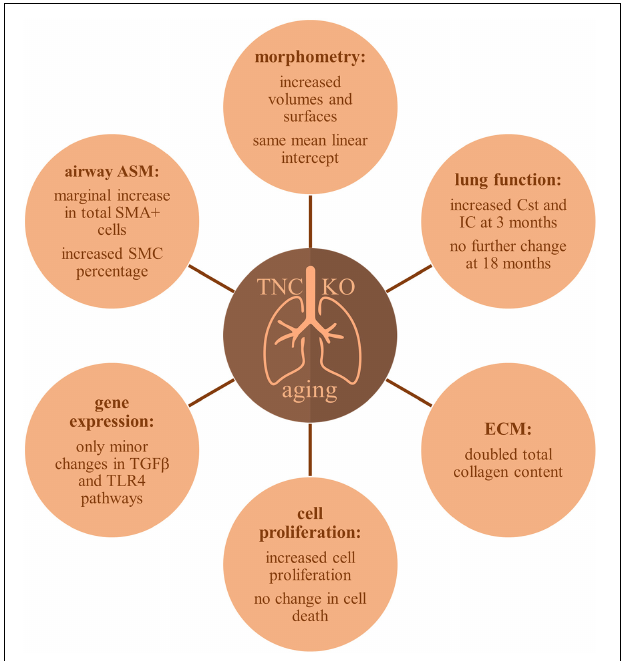
FIGURE 9 | Schematic overview of TNC inactivation effects in aging